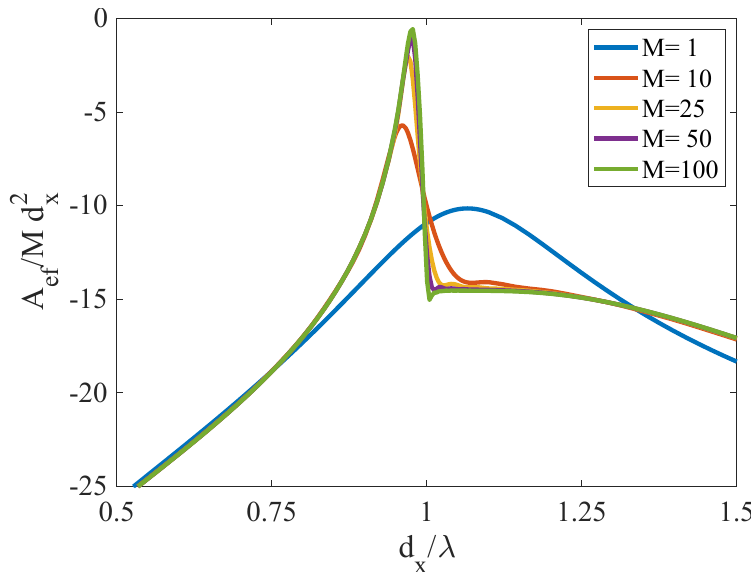
Figure 3. Normalized effective transmitting area of a finite chain of M slots with dimensions l s = 0.4 d x , w s = 0.05 d x for different values of M under plane wave illumination at normal incidence.